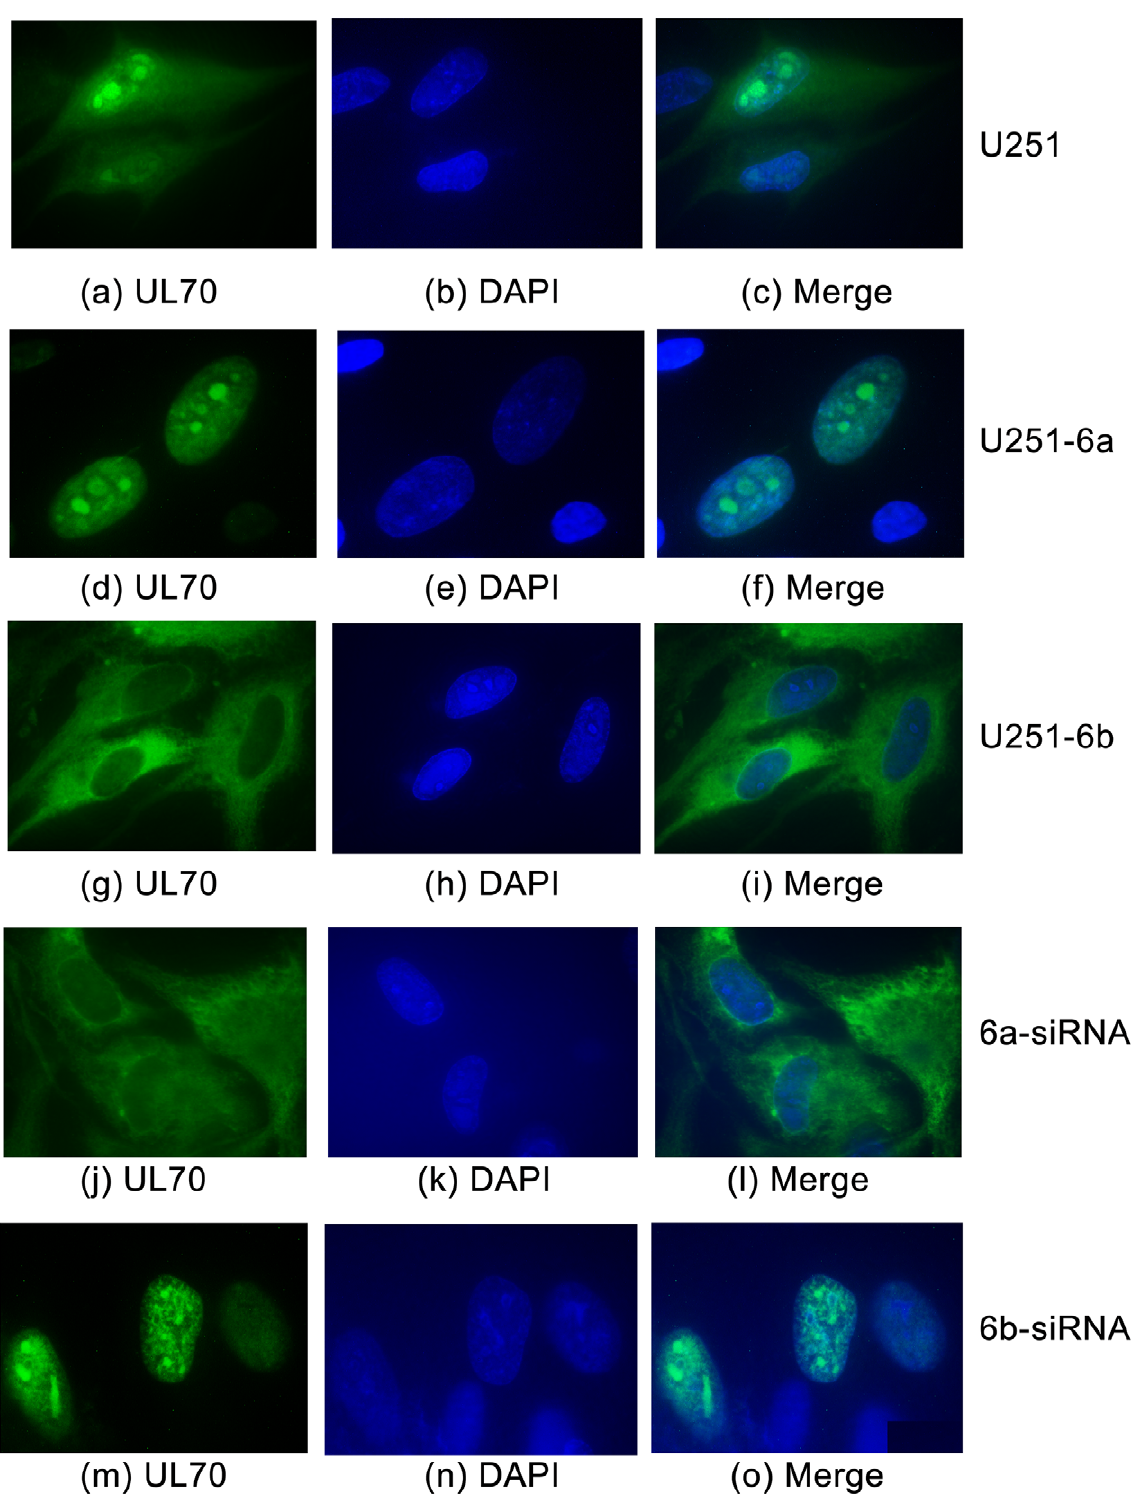
Figure 6. Effect of up- and down-regulation of the expression of DNAJB6 on the cellular distribution of UL70. Immunofluorescence microscopy of the cellular localization of UL70 in the parental U251 cells (U251), cells overexpressing DNAJB6a (U251-6a) and b (U251-6b), or the cells treated with anti-DNAJB6a (6a-siRNA) and anti-DNAJB6b siRNA (6b-siRNA). Cells were infected with HCMV (MOI=5) at 48 hours posttransfection, fixed at 48–72 hours postinfection, stained with antibodies, and visualized. The images of Myc-tagged UL70 (green) (a, d, g, j, m) and the nuclei stained with DAPI (blue) (b, e, h, k, n) were used to generate the composite images (c, f, i, l, o). The images show different levels of magnification.